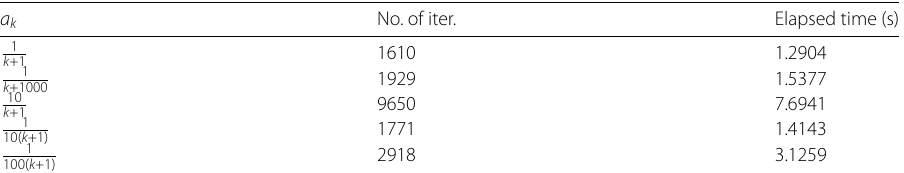
Table 6 Numerical results of a k